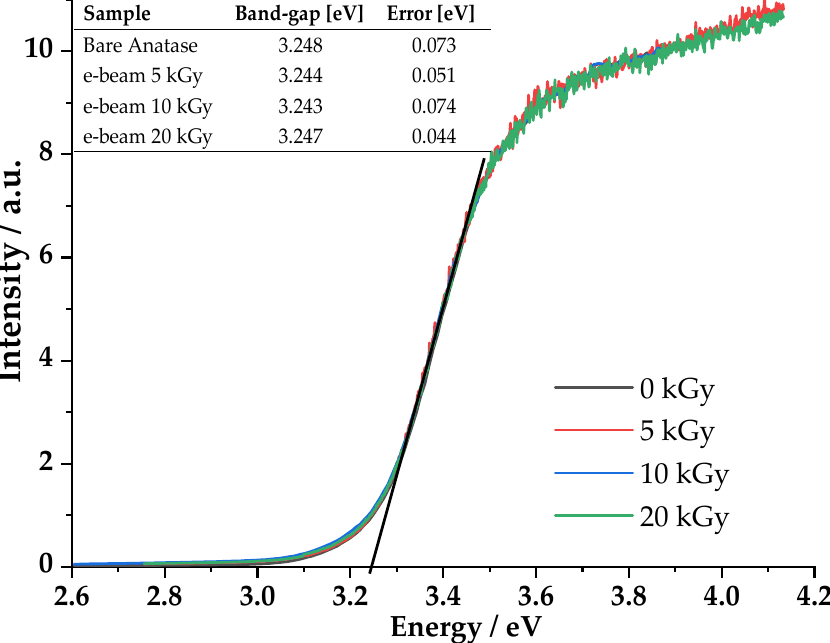
Figure 5. Diffuse Reflectance Spectroscopy (DRS) spectra of TiO 2 with and without e-beam treatment are displayed. Inset, the band gaps estimated from the DRS spectra are summarized.